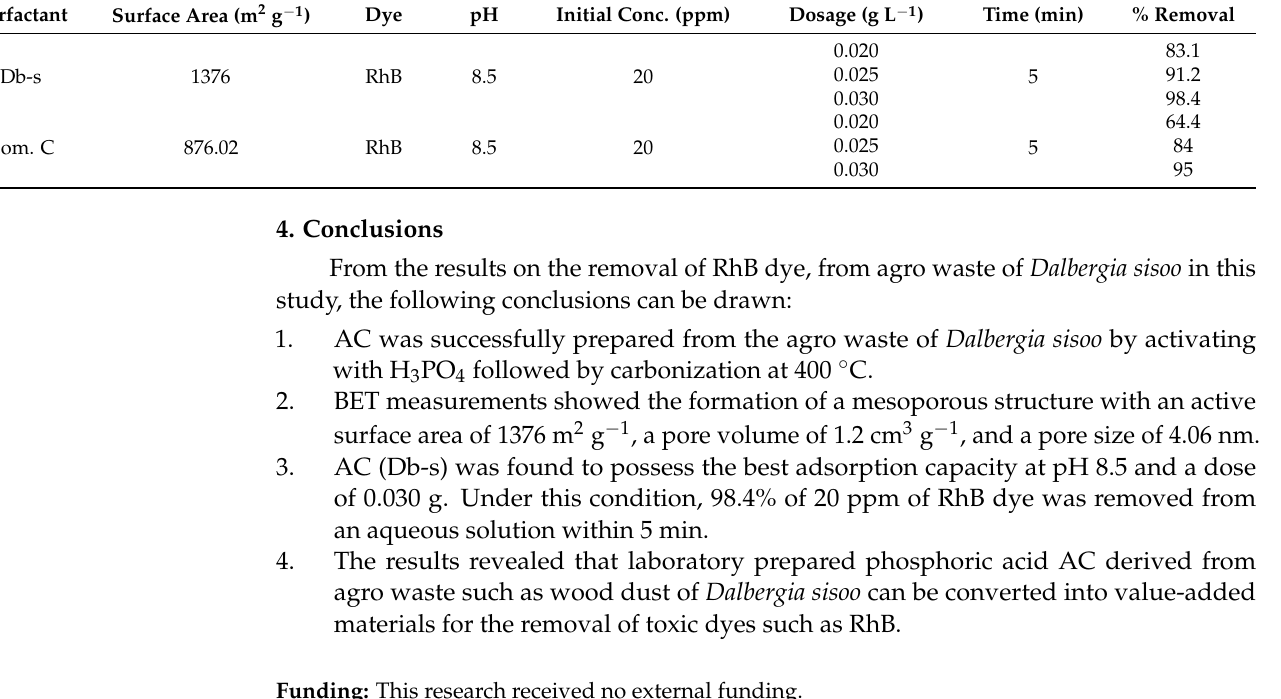
Table 9. Details of the comparison of the % removal of RhB dye using different doses of AC (Db-s) and commercial carbon.